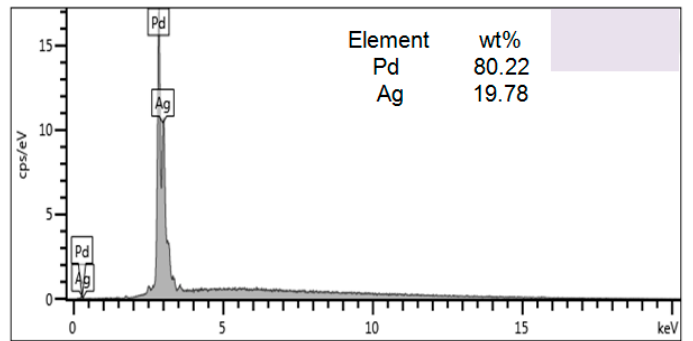
Figure 4. Spectral diagram of film elements.